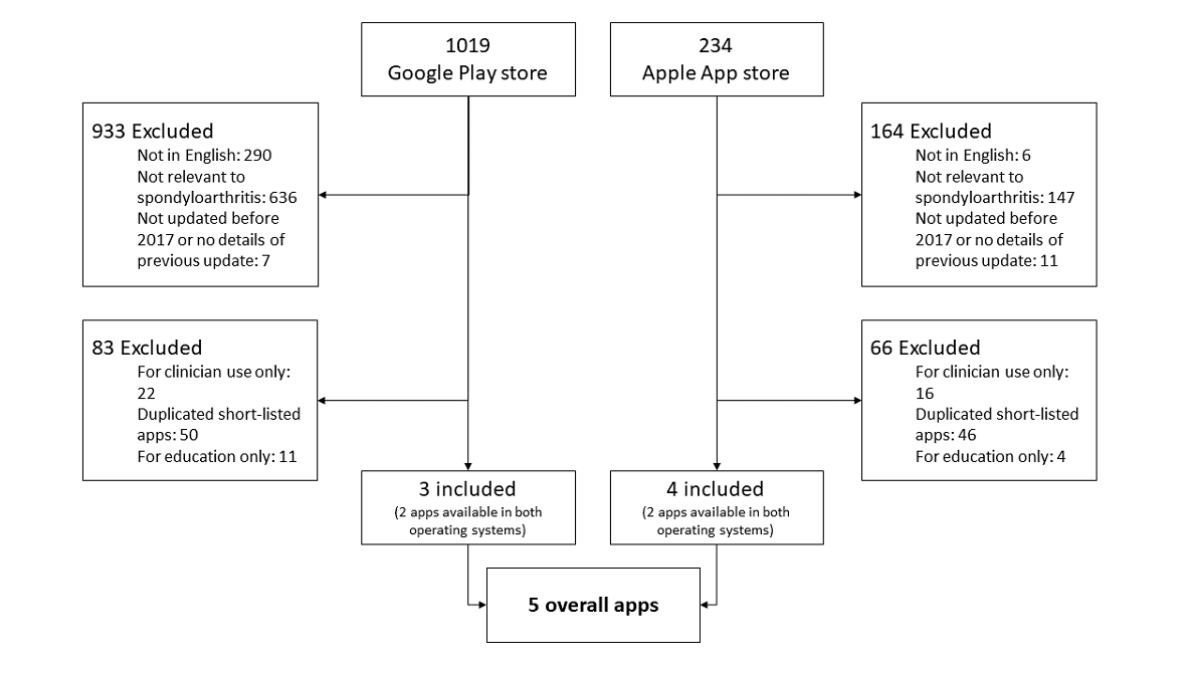
Figure 1. Flow diagram of systematic app search and selection from the Google Play Store and Apple App Store.